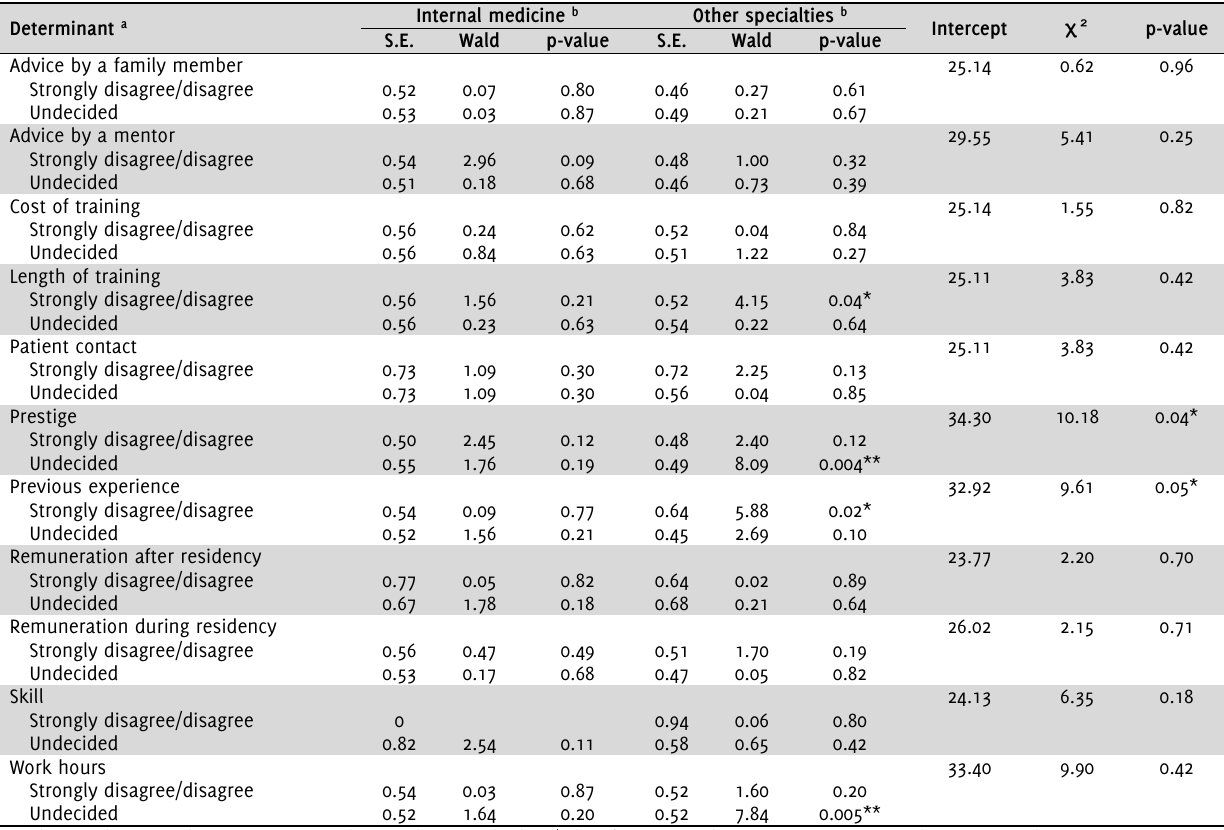
Table 3 . Multinomial Regression Analysis of Specialty Determinants and Medical Students’ Specialty